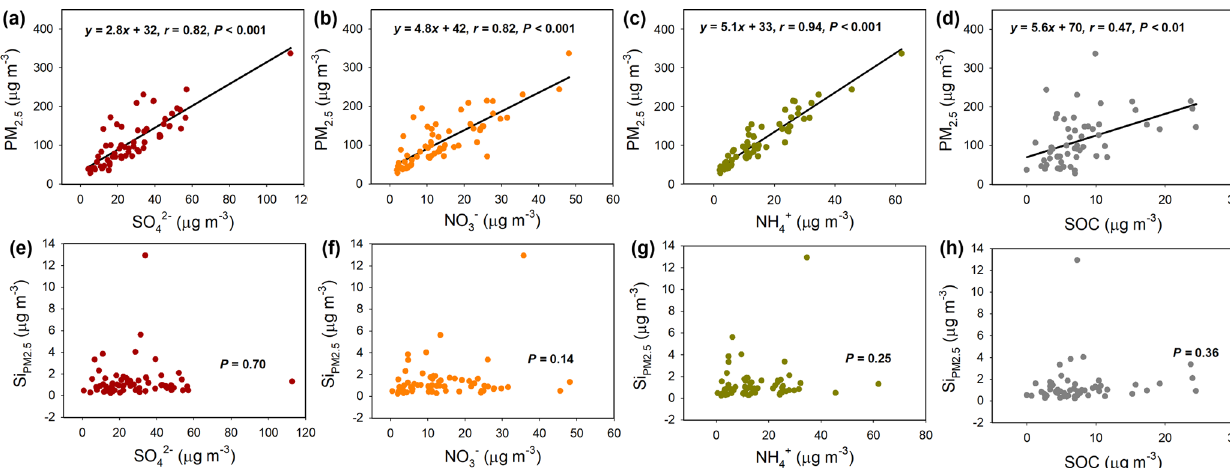
Figure 2. Correlation analysis of PM 2 . 5 concentration and its Si content (Si PM of PM 2 . 5 concentration with SO 2 − and SOC (h) .